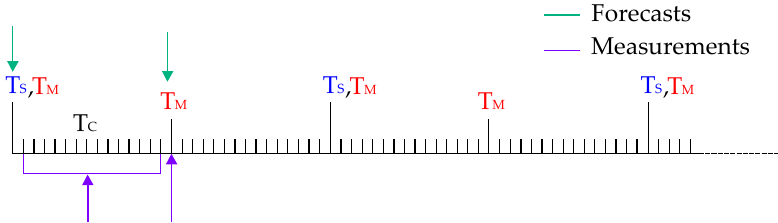
Figure 2. Framework of the hierarchical control.